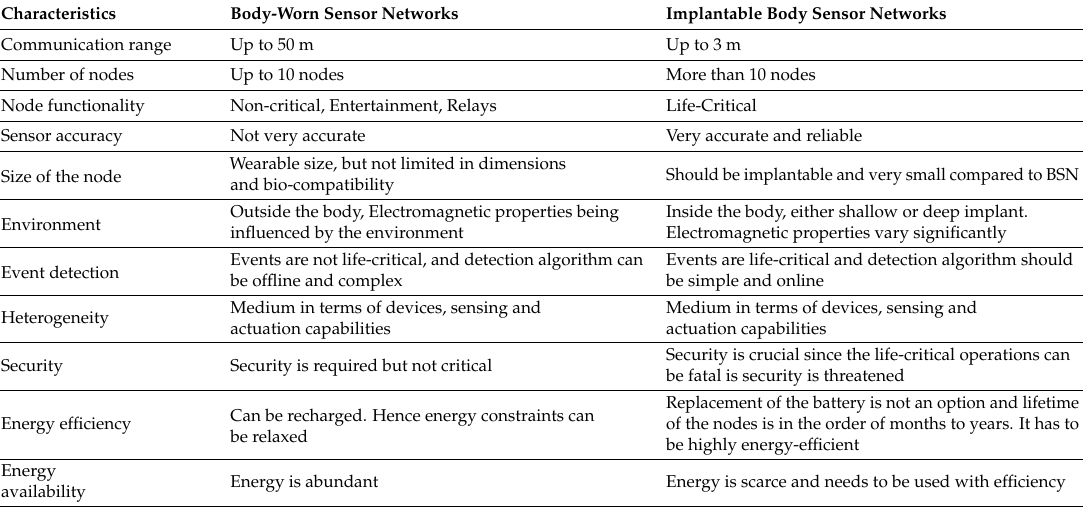
Table 1. Differences between the requirements of BSN and IBSN. Inspired from